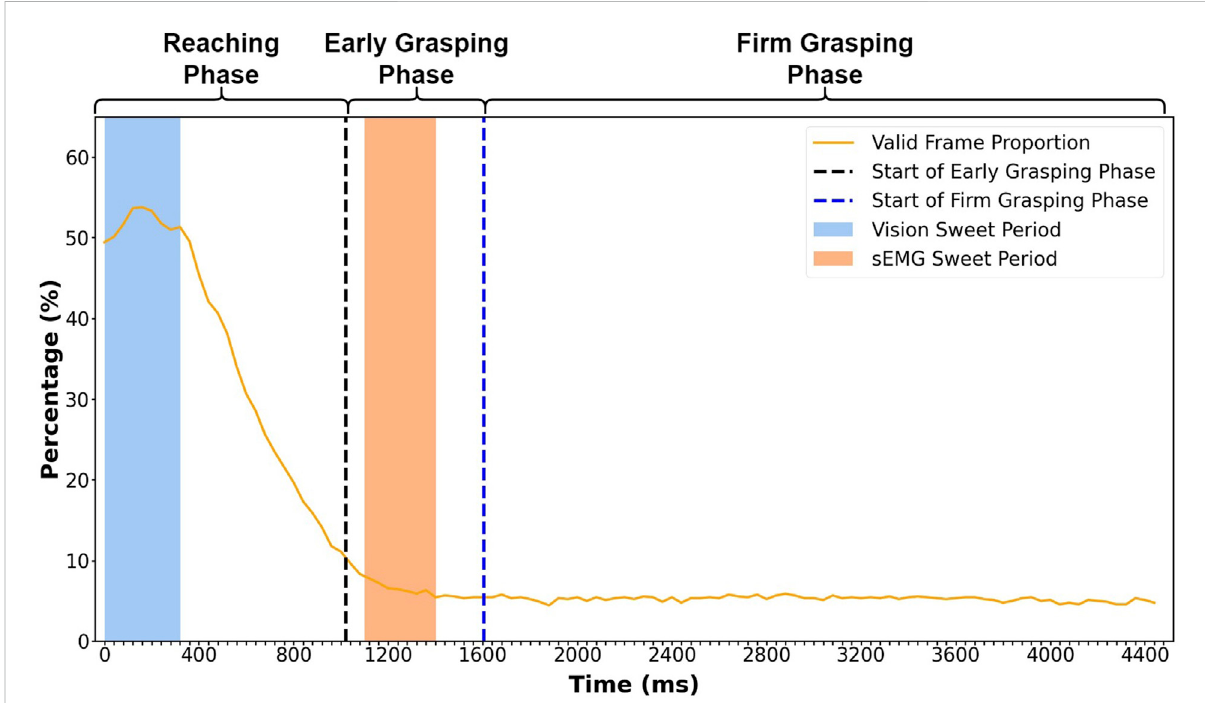
FIGURE 4 Validframeproportionateachtimepointduring theentiregrasping process.The percentage representstheaverageproportionofvalidframes in 900 trials from 30 subjects. The x -axis contains 112 points representing 112 frames in a grasp trial (40 ms for each frame, 4,480 ms in total). The vision sweet period starts from 0 ms and ends at 320 ms. The sEMG sweet period starts at 1,100 ms and ends at 1,400 ms. The vertical dashed lines are averaged starting times of the early grasping and fi rm grasping phases, which locate at 1,020 ms and 1,604 ms, respectively. The result is calculated with leave-one-repetition-out